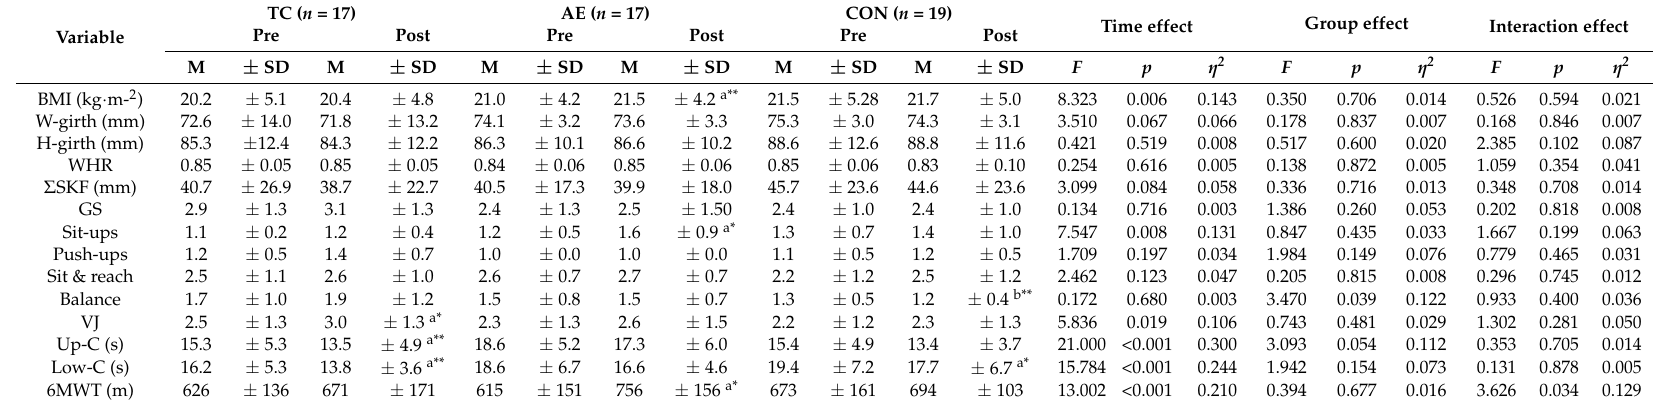
Table 2. Anthropometric and physical fitness outcomes before and after 12 weeks of intervention.